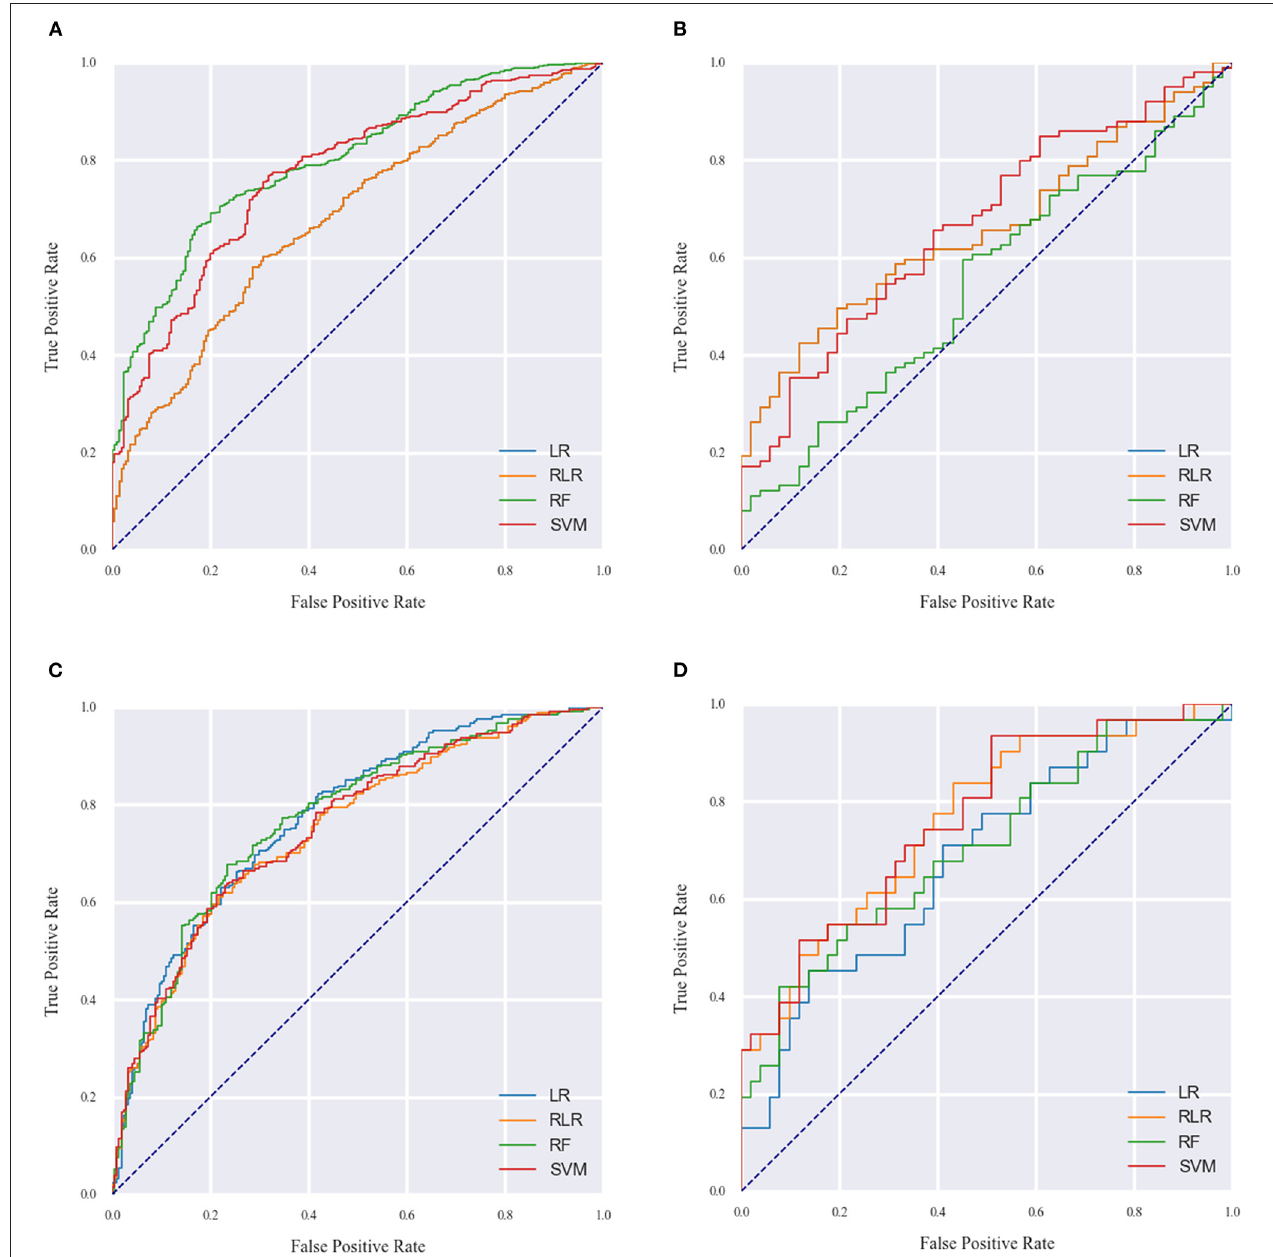
FIGURE 4 | The AUC of the machine learning models for model 1 (A,B) and model 2 (C,D) on the derivation and external validation cohort data. LR indicates logistic regression without regularization; RF, random forest; RLR, regularized logistic regression, SVM, support vector machine.